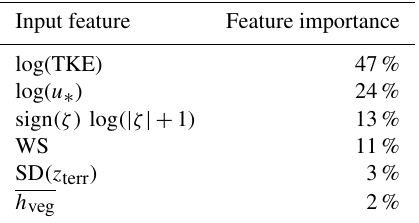
Table 4. Feature importance classification as derived from the ran- dom